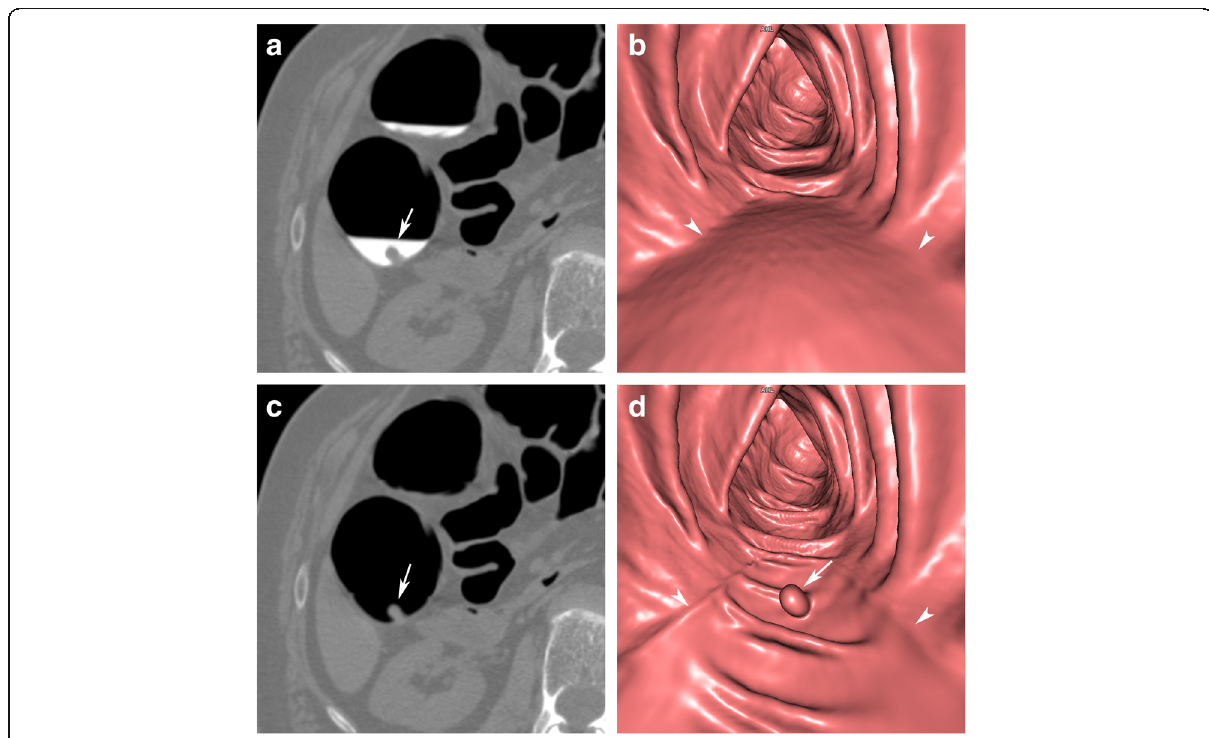
Fig. 1 Sessile polyp in the ascending colon, submerged entirely under tagged residual fluid. a Axial 2D view shows a sessile polyp (arrow) with a homogeneous soft tissue attenuation within the tagged hyper-dense fluid. b In the corresponding endoluminal view, only a horizontal fluid layer is seen (arrowheads). c After EC, the tagged fluid is subtracted from the 2D view. d The polyp also becomes visible on endoluminal 3D views and presents with a round shape and a smooth surface (arrow). A linear artefact often occurs at the air-fluid interface (arrowheads). It helps to identify parts of the colon wall that were originally submerged. Note that the haustral folds are